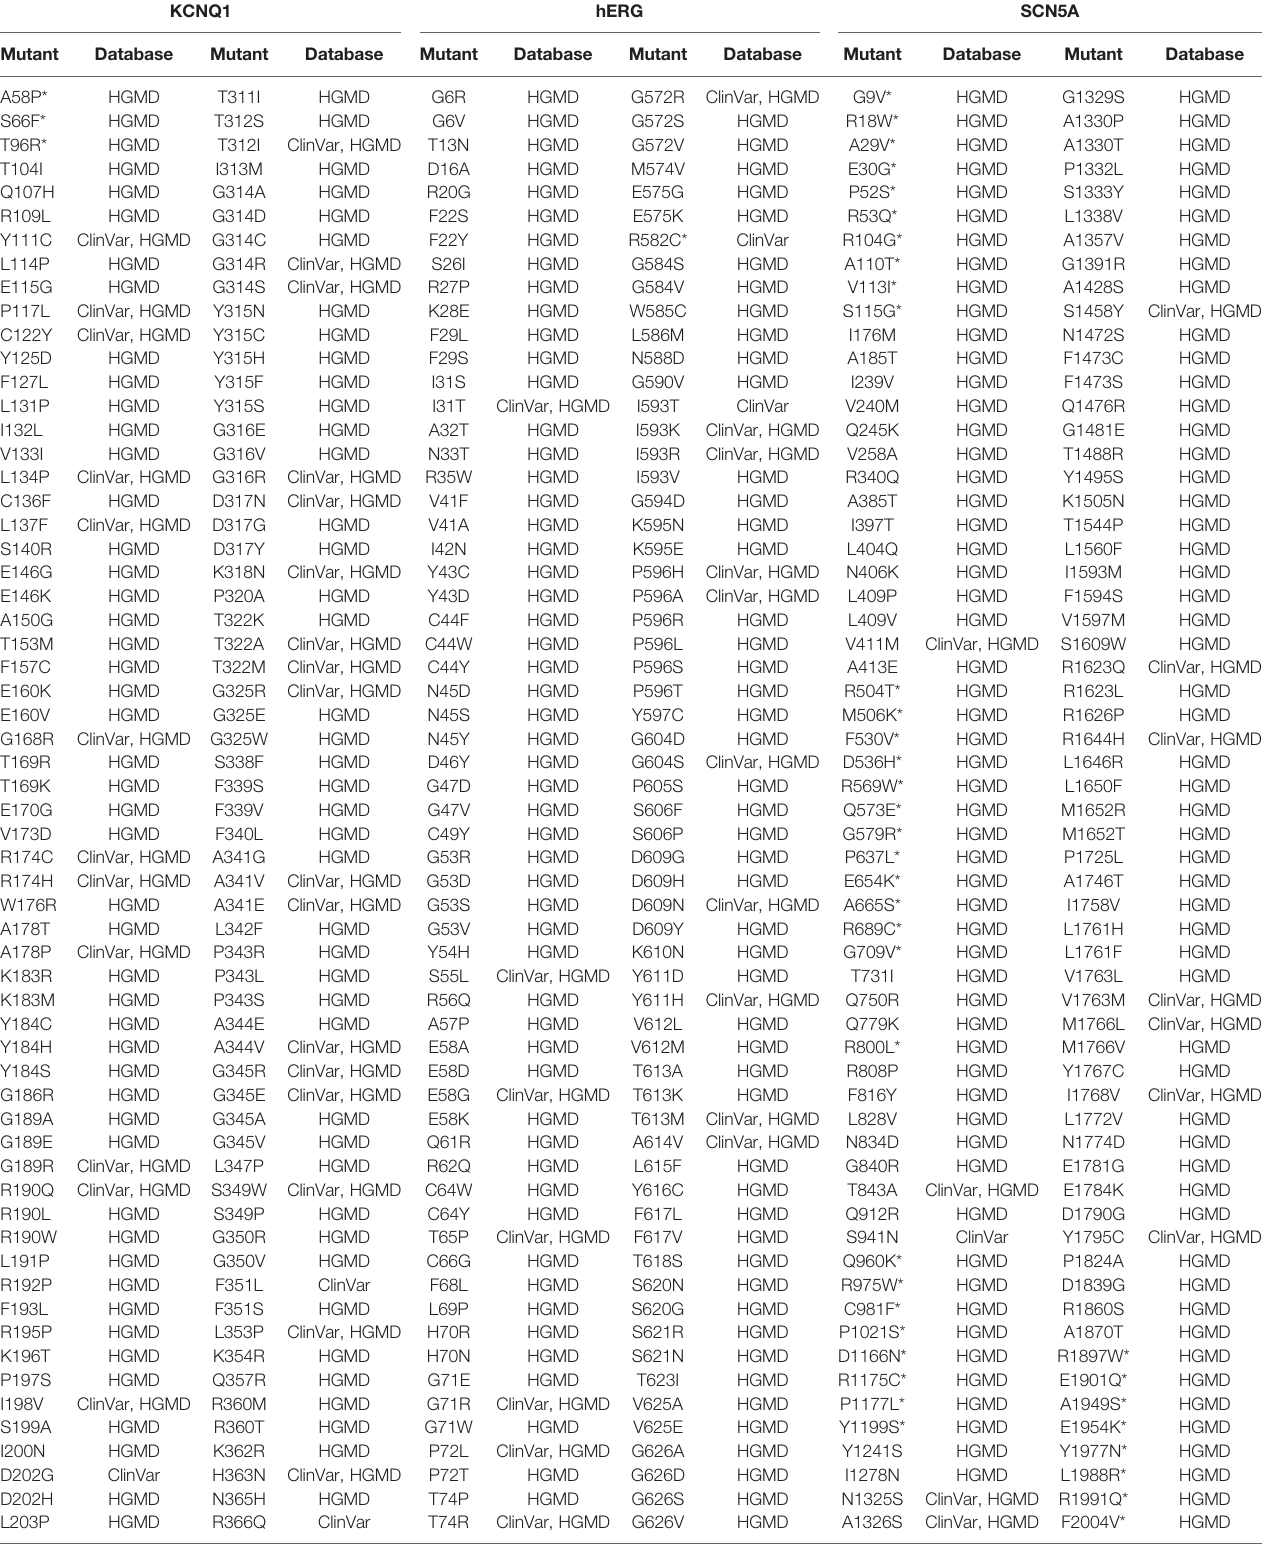
TABLE 1 | LQTS mutations in KCNQ1, hERG, and SCN5A.